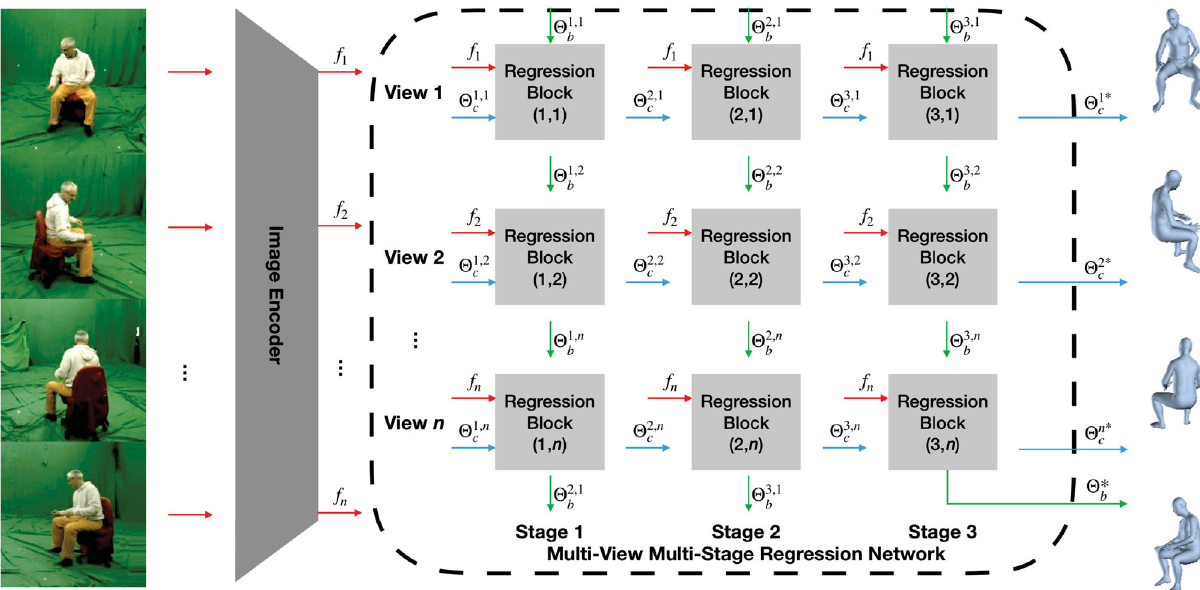
Fig. 1 Network structure from Ref. [18]. By using an iterative value correction structure, visual information from different views is effectively integrated to provide a unified human shape. Reproduced with permission from Ref. [18], c (cid:2) The Author(s) 2019.